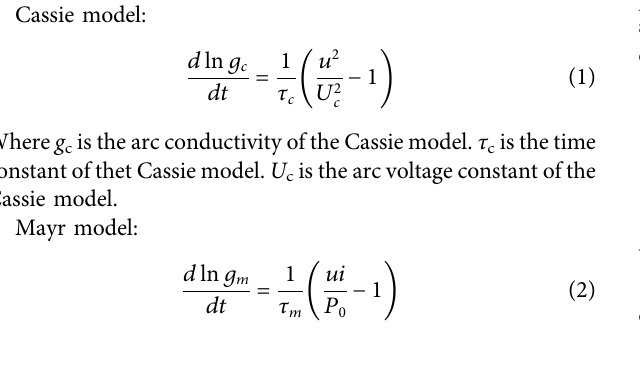
Frontiers in Energy Research |